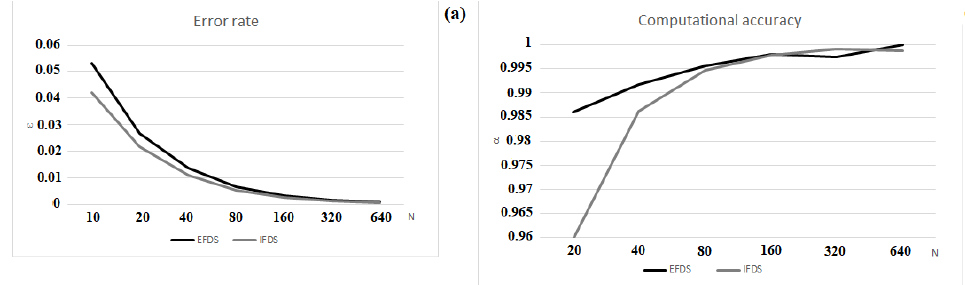
Figure 6. ( a ) Error ε , ( b ) computational accuracy α .